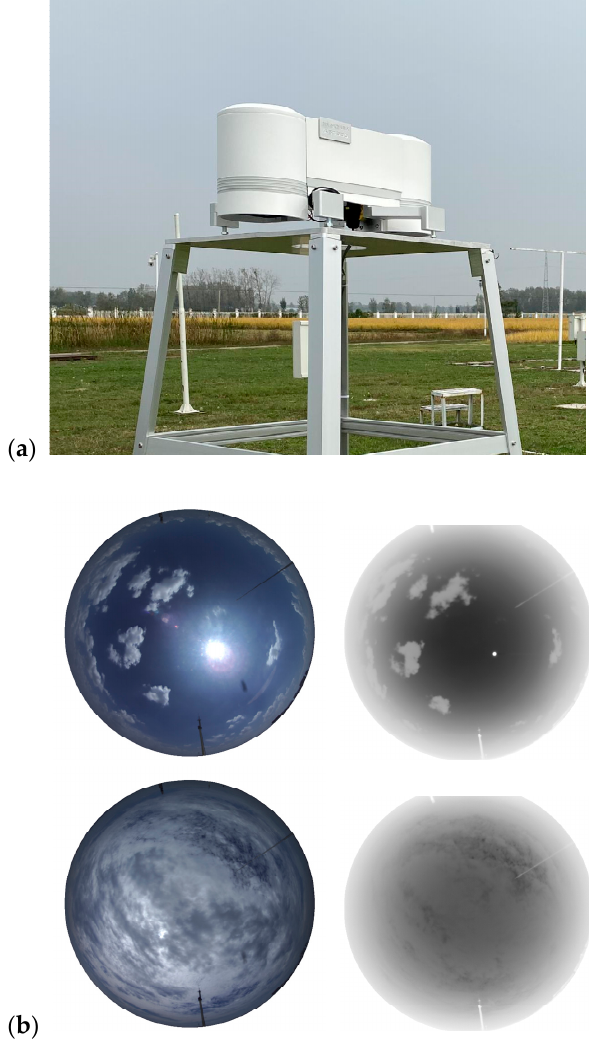
Figure 1. ( a ) All-sky camera 200 (ASC-200). ( b ) Two sets of visible (left) and infrared (right) all-sky images captured by ASC-200.